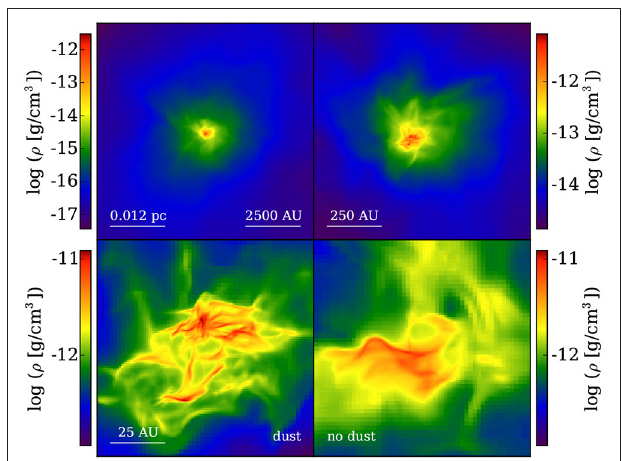
FIGURE 5 | The collapse of metal-enriched gas from scales of 2000 AU down to 100 AU, where dust cooling cause the cloud to fragment. The bottom-right shows the result of the same collapse without the effects of dust. A reproduction of Figure 6 from Smith et al.